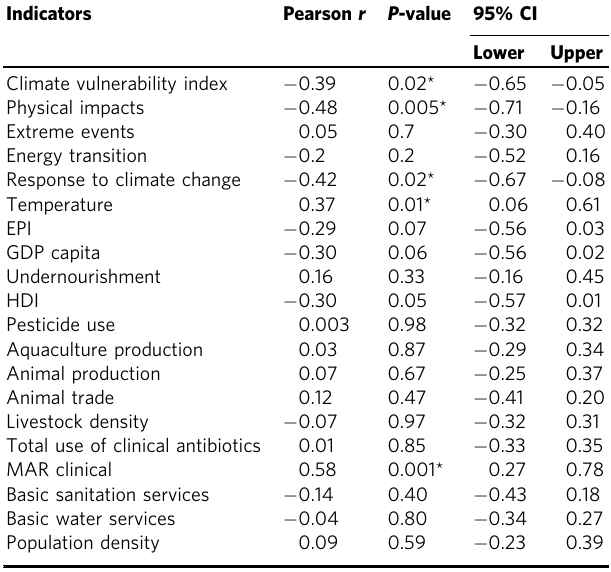
*Indicates statistical signi fi cance ( P